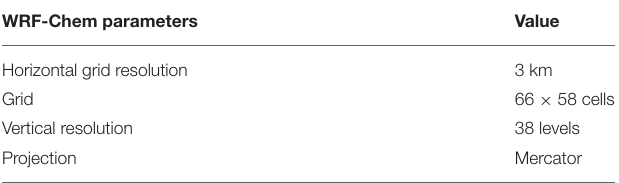
TABLE 1 | WRF-WPS model setup. TABLE 2 | Relative risk for the diseases from epidemiological study done by Pope et al.